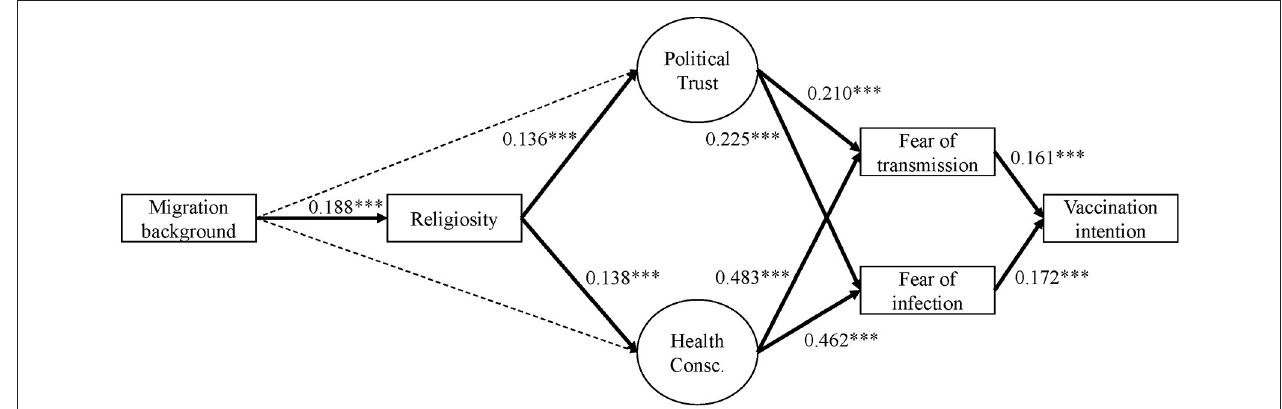
FIGURE 2 | Empirical model 1, all respondents (standardized) 4 .